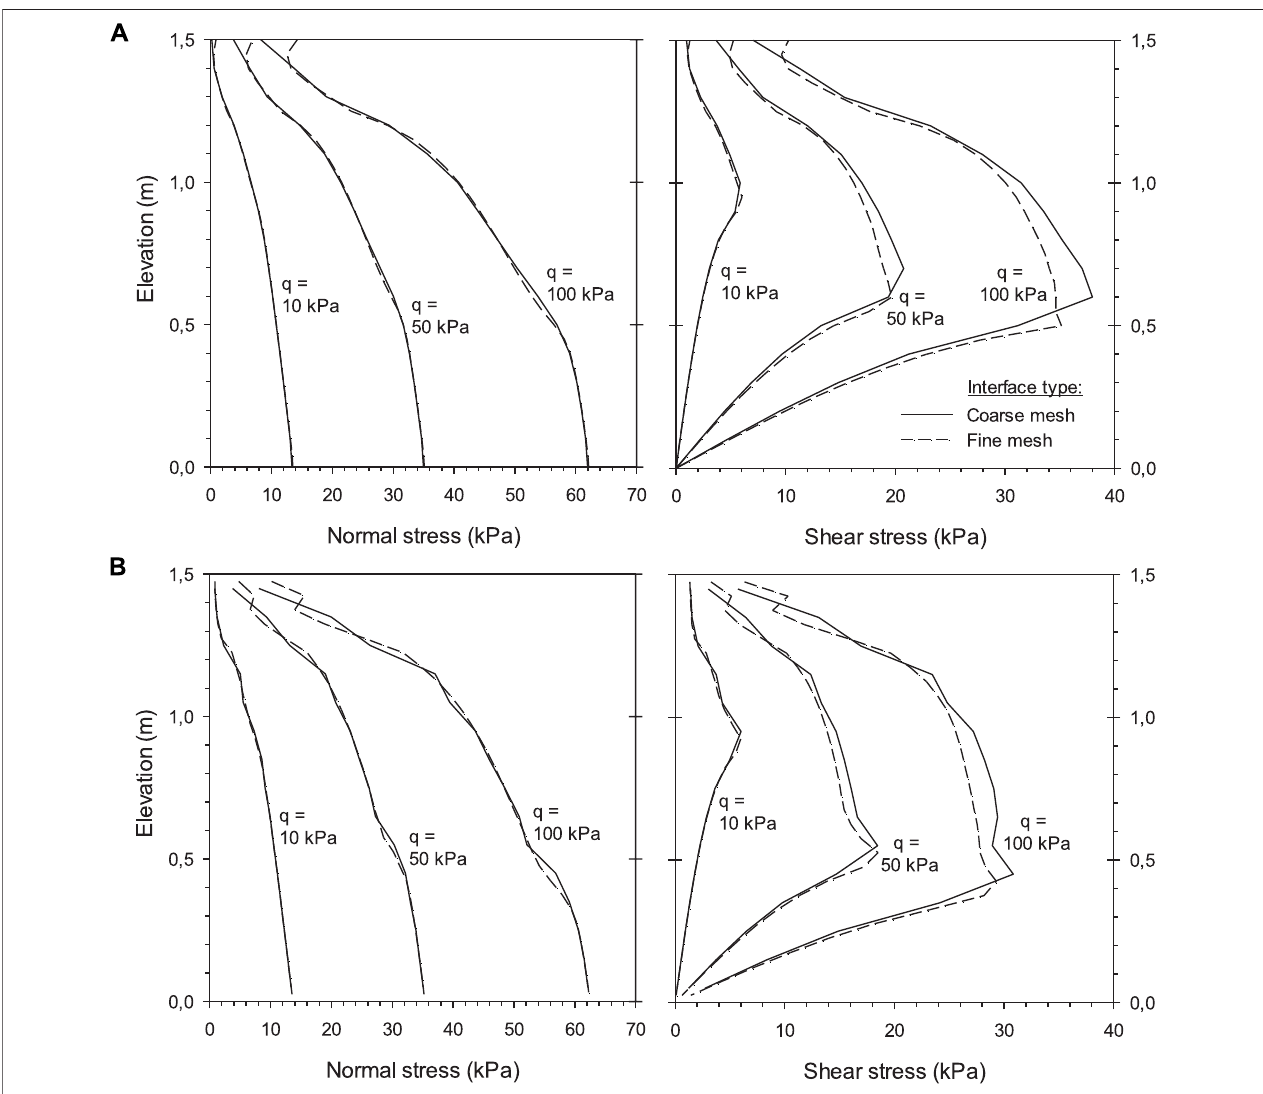
FIGURE6| Comparisonofloadtransferresultsfromback fi llsoiltofacingpanelusingFLACwith (A) springand (B) continuuminterfaceelementswithcoarsemesh and fi ne mesh: normal and shear stresses at the interface between the facing structure and back fi ll soil for a strength/stiffness reduction factor Ri = 0.8.